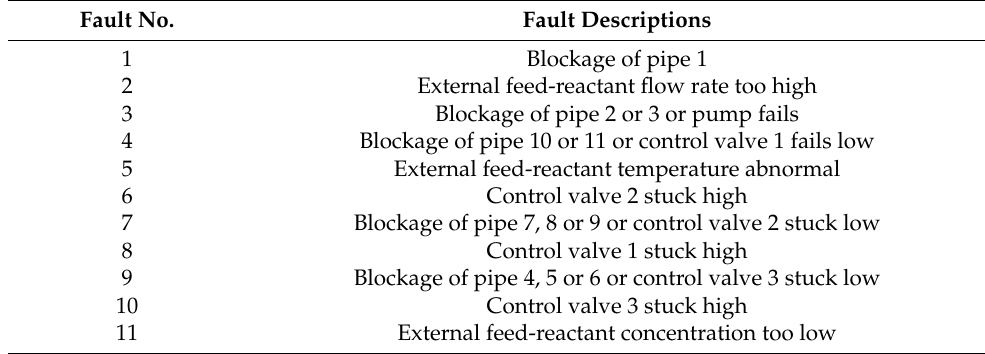
Table 1. List of faults. Fault No.